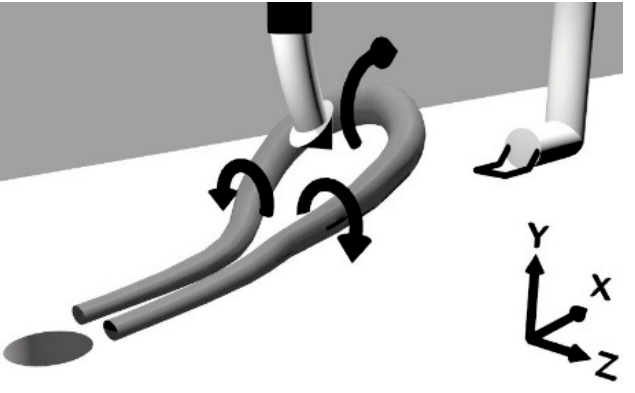
Figure 6. Conceptual illustration of the control strategy.